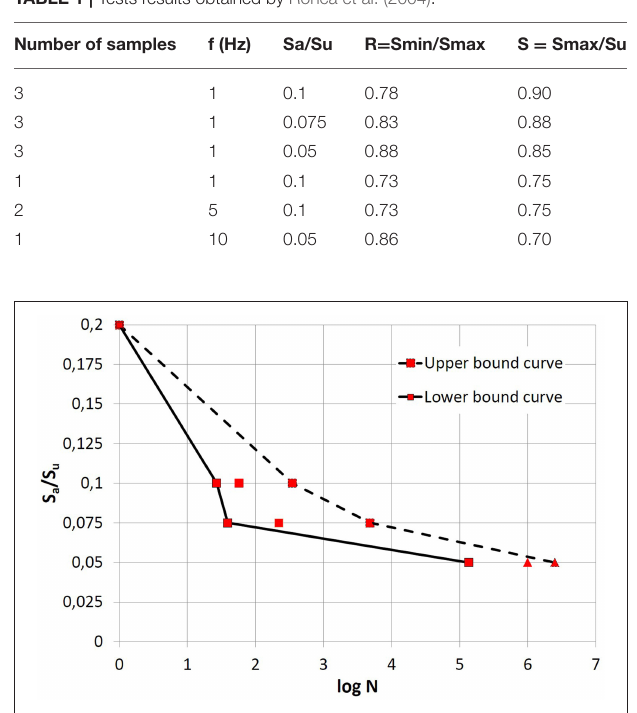
TABLE 2 | Casas (2009) coefficients for different values of survival probability